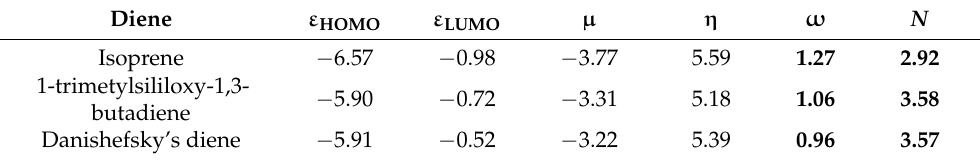
Table 3. Global properties calculated using B3LYP method and 6-311+G(d,p) level of theory.